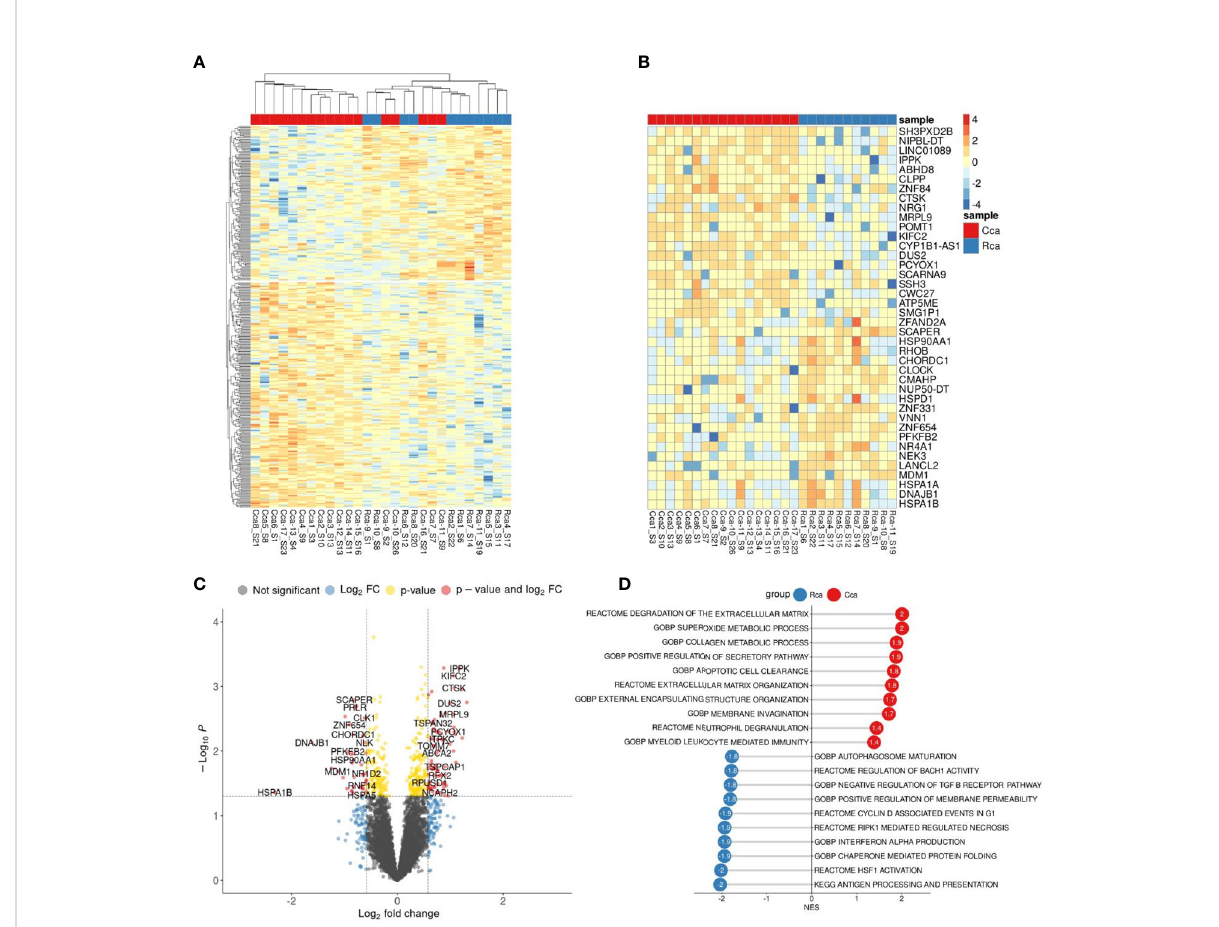
FIGURE 4 Comparative transcriptome of monocytes from colon cancer (CC) and rectal cancer (RC) patients. (A) , Heatmap demonstrates hierarchical clustering of samples and upregulated and downregulated genes in monocytes of CRC patients (FDR<0.25). (B) , Heatmap with top 20 DEGs in monocytes of colon and rectal cancers (FDR<0.25). (C) , Volcano plot shows p-value and log2 fold-change value for DEGs in monocytes of colon and rectal cancers (|L2FC|>0.58, FDR<0.25). (D) , Bar plot with GSEA results demonstrates top deregulated pathways in monocytes of colon and rectal cancers